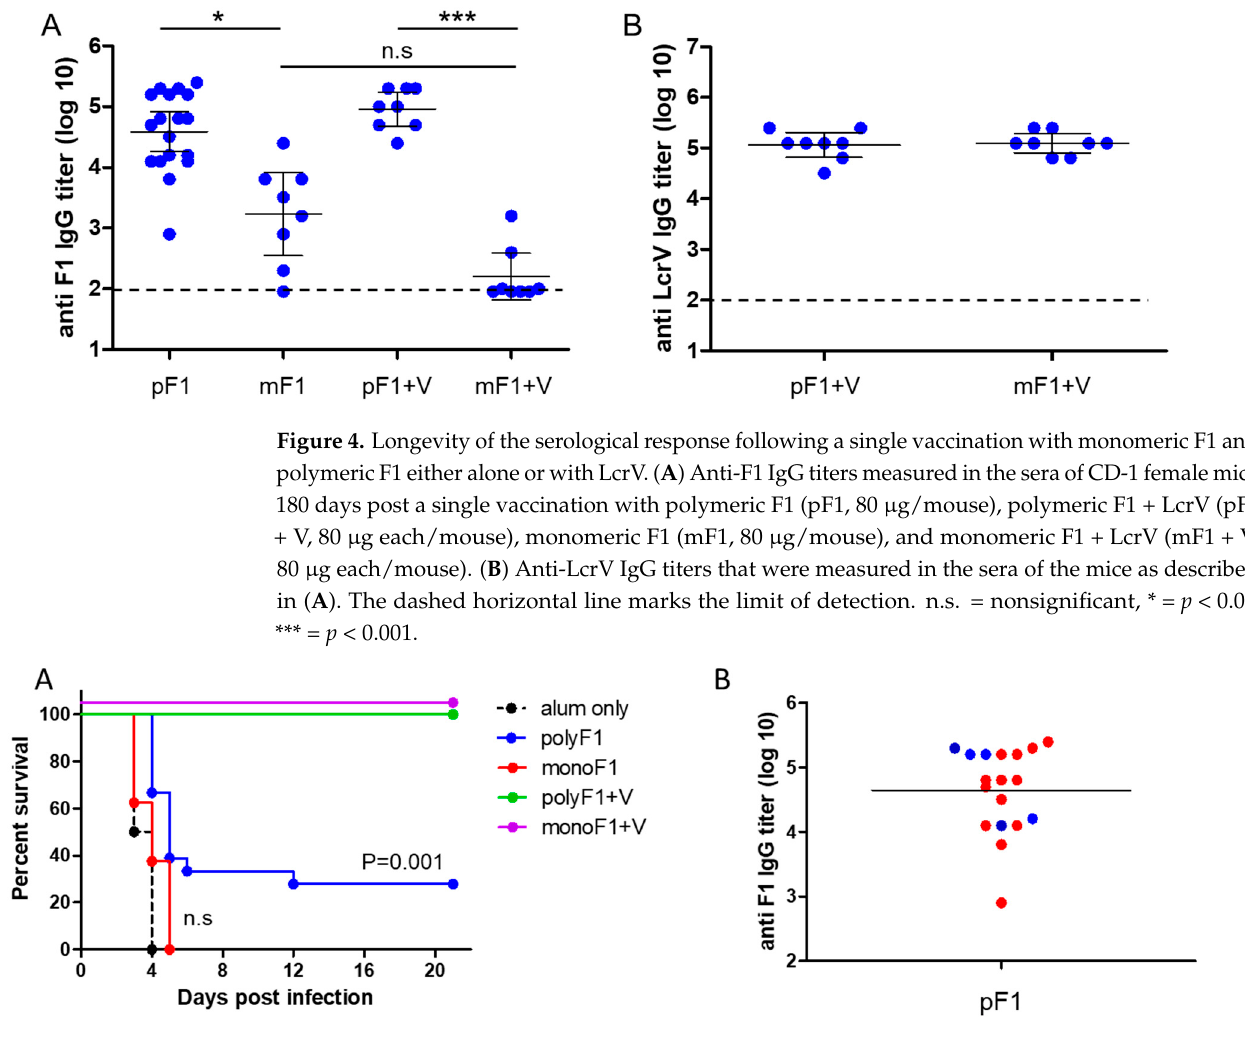
Figure 5. Longevity of immunity afforded by a single vaccination with monomeric F1 and polymeric F1 and LcrV in the mouse model of pneumonic plague. ( A ) Survival curves of female CD-1 mice vaccinated, as described in Figure 4, and challenged intranasally with Y. pestis Kim53 (100 LD50) 183 days after the administration of the vaccine. Mortality curves of control animals vaccinated only with AlOH are shown by black dashed lines. p values calculated by the log-rank test toward control AlOH-vaccinated animals are shown. n.s. = nonsignificant. ( B ) Correlation between the anti-F1 IgG titers measured in the serum of female mice prior to the challenge described above. Animals that survived the challenge are marked with blue symbols, and those that succumbed to the infection are marked with red